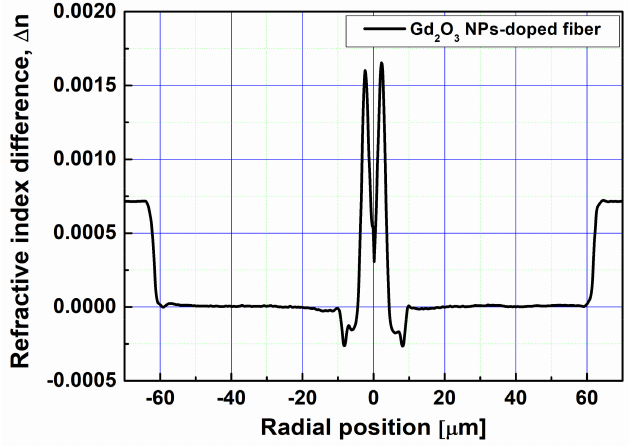
Figure 1. Refractive index profile of the Gd 2 O 3 NPs-doped